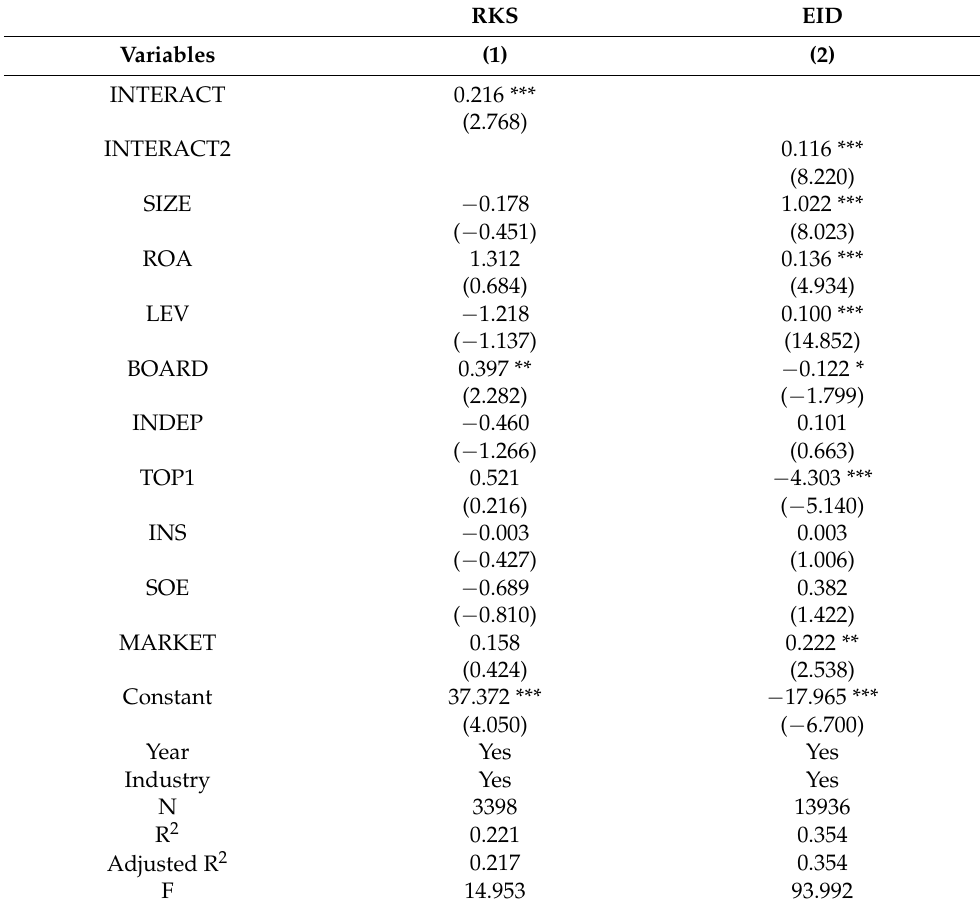
Table 5. Results of robustness